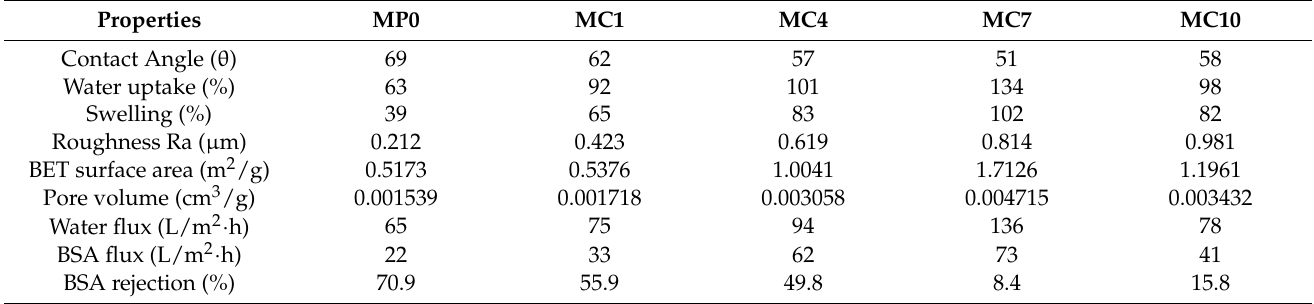
Table 4. Characteristics of the fabricated PES pristine and modified AC incorporated